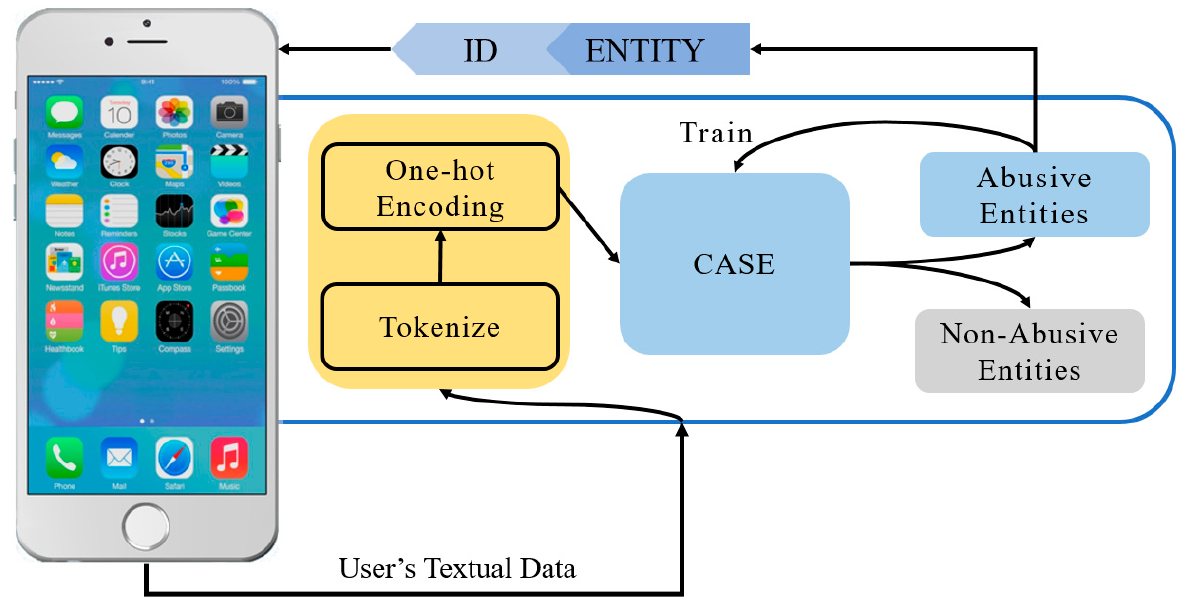
Figure 2. System-level Module of MaLang.